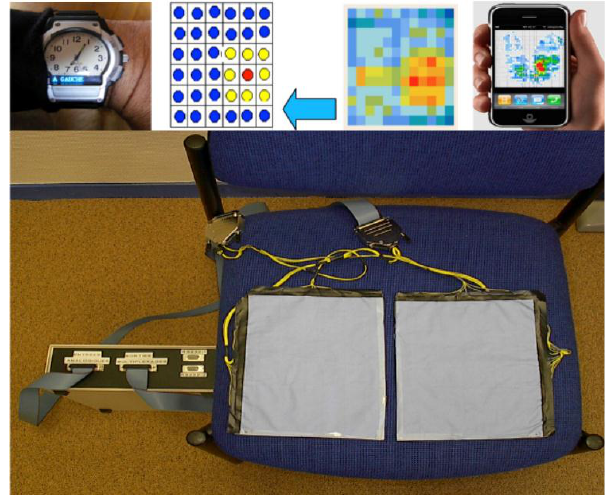
Figure 14. Original device recording the pressure on the buttock (adapted from [143]). Top left: the signal on the watch indicates the left side, opposite to where the pressure is the greatest. Top center: discretization of the information of pressure. Top right: same information given on a smartphone. Bottom: pressure recorder cushion. Eventually, the fusion algorithm can be extended to other physiological parameters, such as weight or blood pressure, but with an observation window whose precise duration has to be adjusted to be significant. For instance, a drop of 10% in body weight, detected over a three-month period, could be the main signal of an early cancer diagnosis. An important problem to address in